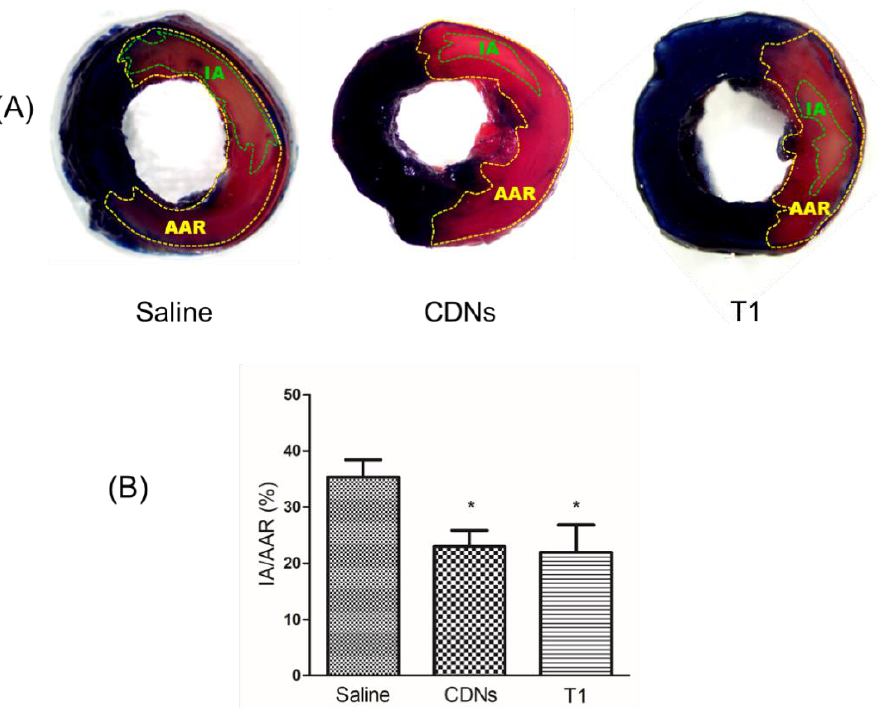
Figure 6. Cardioprotective effect of CDNs and trehalose-lyoprotected CDNs (T1). CDNs or saline were injected to the mice via tail vein 5 min before reperfusion and the infarct size was measured 24 h after reperfusion. ( A ) Representative images indicating IA and AAR for saline control, fresh CDNs, and trehalose-lyoprotected CDN (T1)-treated mice after TTC staining. ( B ) Infarct size was expressed as IA/AAR (%). Data represent mean ± SEM, n = 8–10 mice per group, * p < 0.05 compared with saline control. IA, infarcted area, dead heart tissue in pale; AAR, area at risk, the heart tissue not stained in blue.